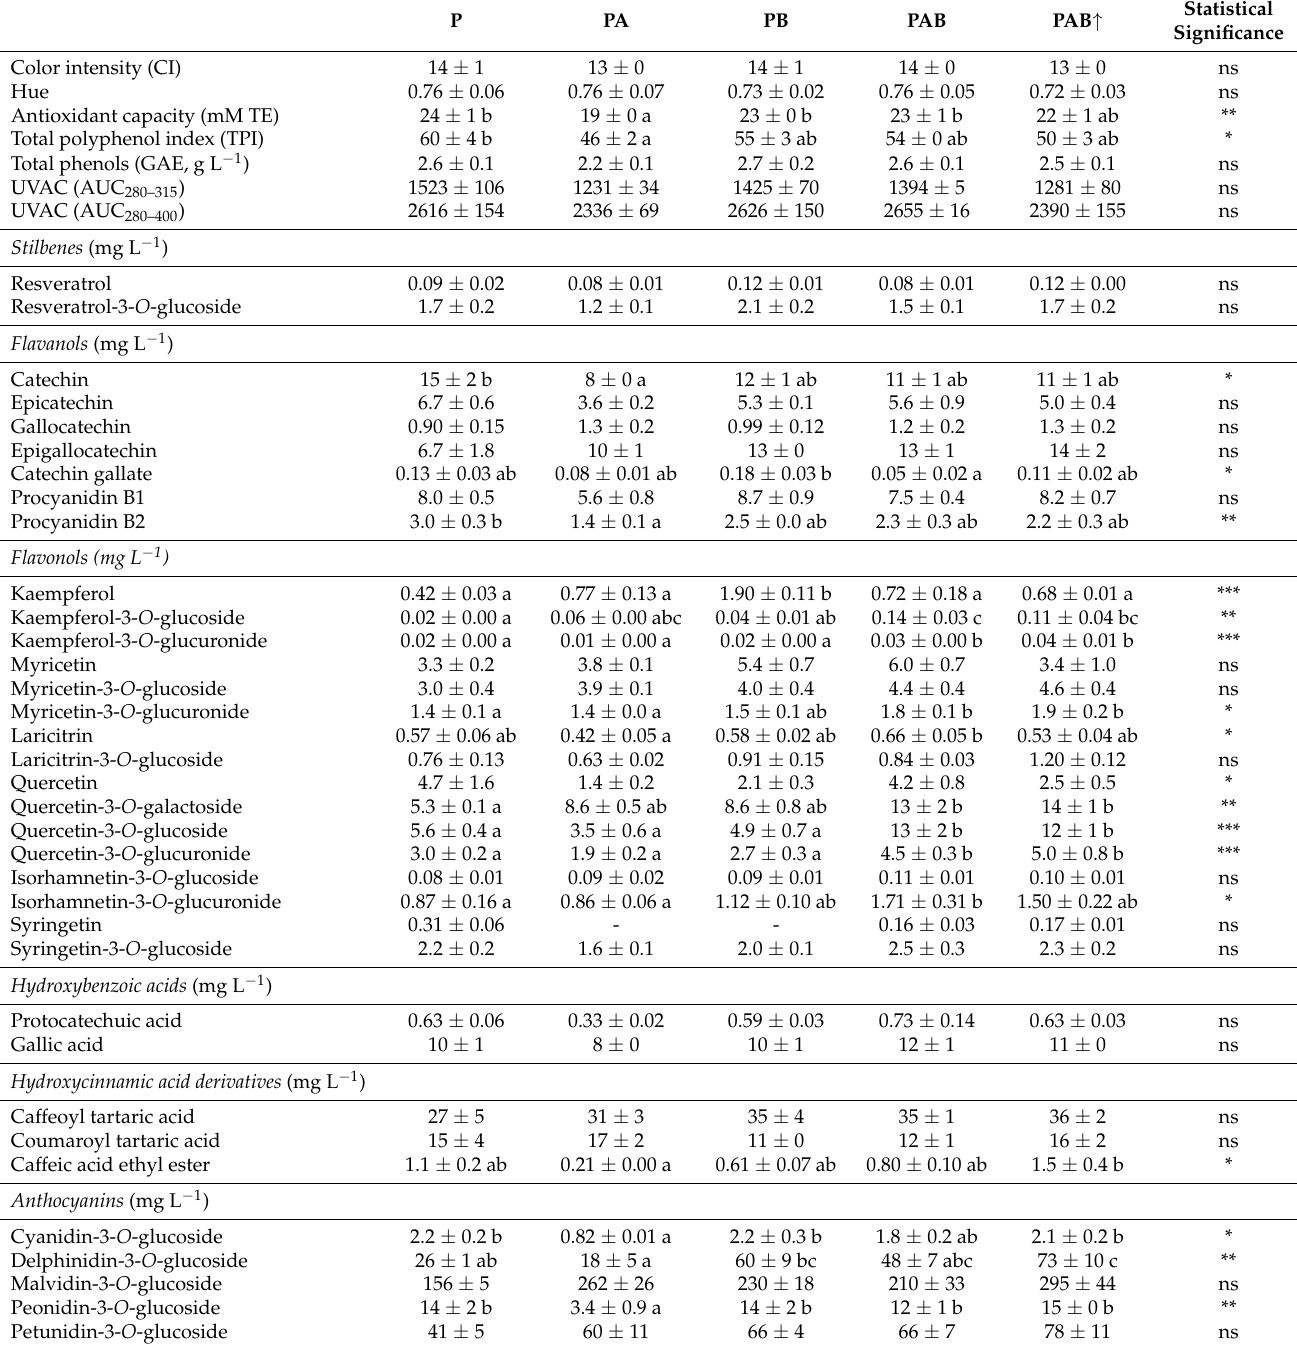
Table 1. Global variables (color intensity, hue, total polyphenol index, total phenols, antioxidant capacity, and bulk levels of UV-absorbing compounds (UVAC)) and individual phenolic compounds in wines made from grapes exposed to five different radiation regimes: P (only PAR), PA (PAR + UV-A), PB (PAR + UV-B), PAB (PAR + UV-A + UV-B), and PAB ↑ (PAR + UV-A + enhanced UV-B). For each variable, the statistical significance of a one-way ANOVA test using the radiation regime as the main factor is shown, and different letters indicate significant differences between radiation regimes (Tukey test). Means ± SE are shown. *** p < 0.001; ** p < 0.01; * p < 0.05; ns, not significant. GAE, gallic acid equivalent. TE, Trolox equivalent. AUC 280–315 and AUC 280–400 , area under the absorbance curve in the intervals 280–315 and 280–400 nm,